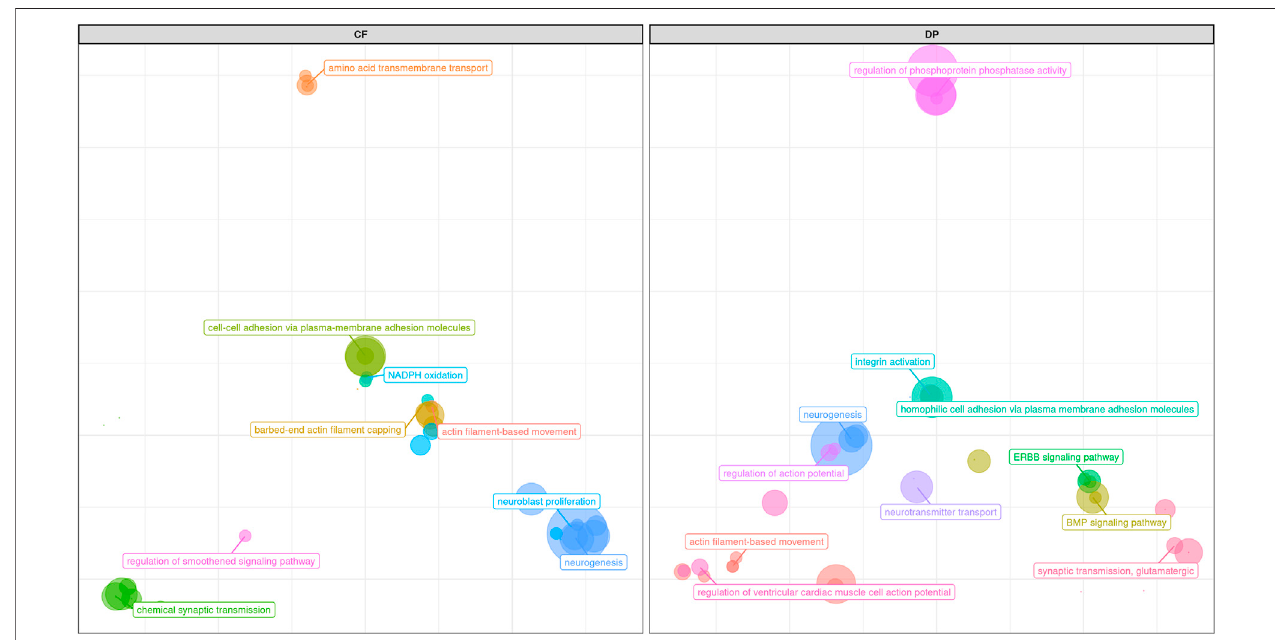
FIGURE 10 | Scatter plot representing the main groups of biological pathways enriched for carcass traits (carcass fl eshiness and dressing percentage). For a detailed list of the pathways enriched by these traits see Supplementary Figures S4G,H .